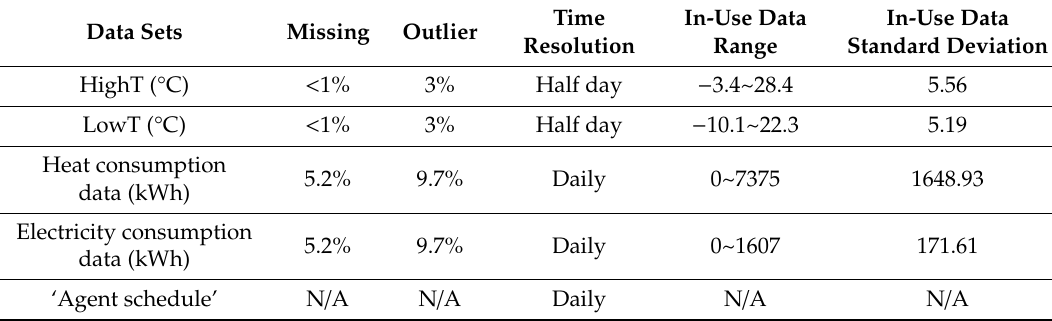
Figure 4. Daily average temperature and total energy comparison for work and weekend days, 2016. Table 1. Dataset summary